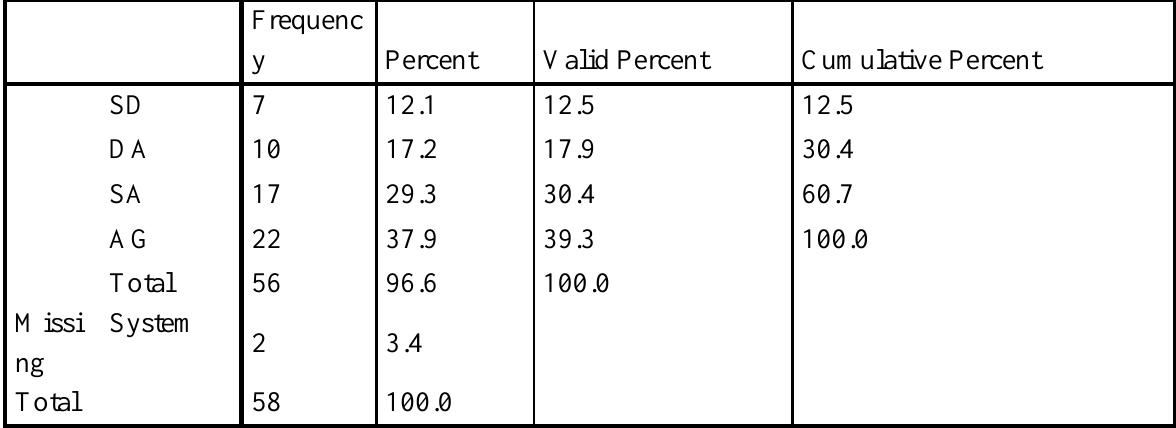
Learning should be given priority over